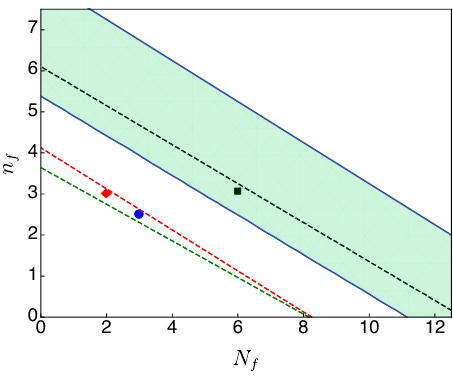
Figure 1. Phase diagram of Sp(4) gauge theory with N f fundamental and n f antisymmetric Dirac fermions. The shaded region denotes the conformal window recently estimated in Ref. [2], while dashed lines denote other analytical estimations in the literature, which are discussed in the same reference. The coloured dots represent the theories realising the phenomenological models discussed in the main